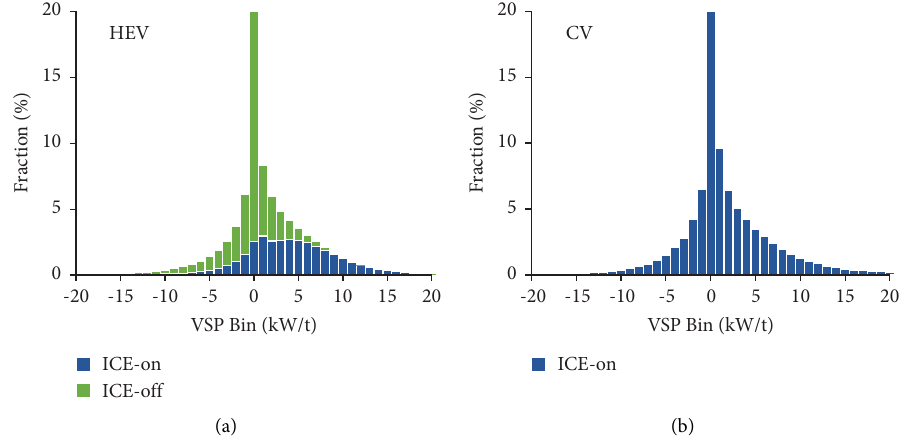
Figure 3: VSP distribution of HEVs and CVs. (a) Te real-world driving data of HEVs, (b) the real-world driving data of CVs.